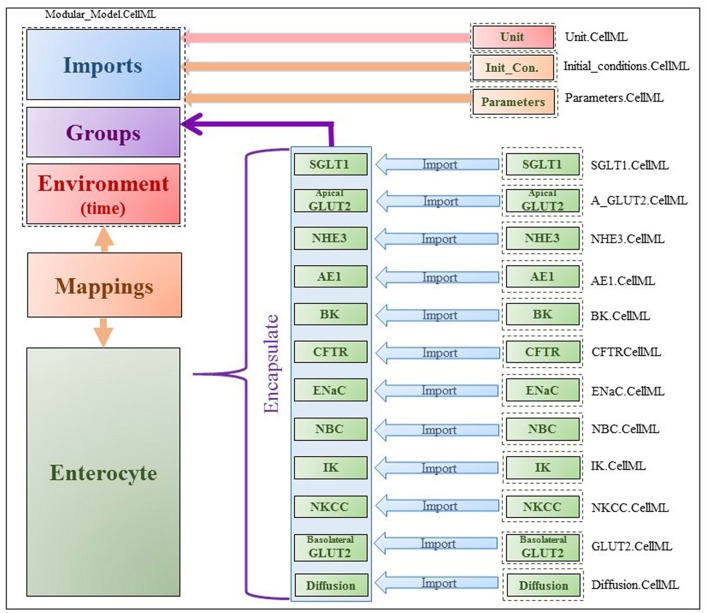
Figure shows the modularity of CellML model. Encapsulation hierarchy (purple), the CellML model imports (blue) and the other key parts (units, parameters, components and mappings) of the top level CellML model.